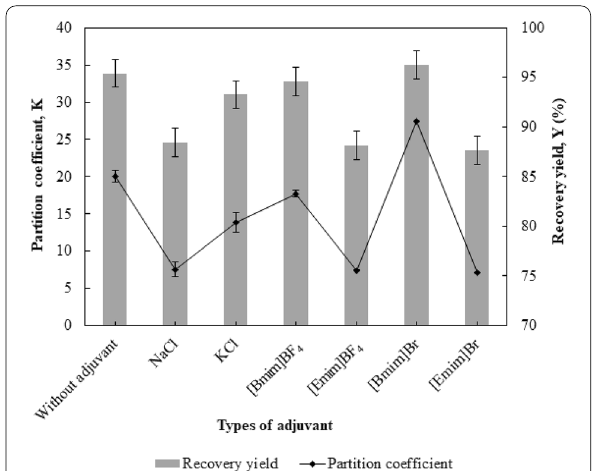
Fig. 5 Effect of types of adjuvants on the partition efficiency of BSA. Neutral salts, such as NaCl and KCl, and ILs, such as [Bmim]BF 4 , [Emim] BF 4 , [Bmim]Br and [Emim]Br, were added at a fixed concentration of 1% (w/w) to the 35% (w/w) 1‑propanol/22% (w/w) maltose ABS at pH 5.0 as adjuvants to evaluate the effect of types of adjuvant on the K and Y of BSA. The results are expressed as mean of triplicate readings